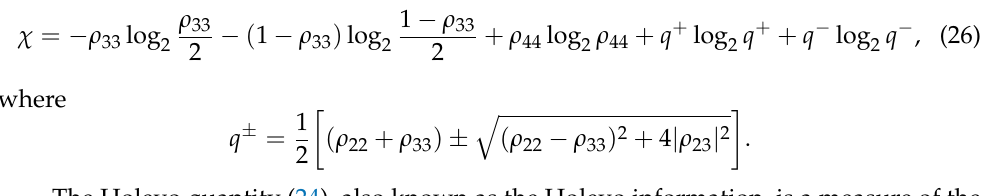
Figure 5. Dense coding capacity (26) as a function of the scaled time τ = γ 0 t when µ = 1/ for different values of Stark shift parameter β . ( a ) Non-Markovian regime with λ = 0.1 γ 0 and ( b ) Markovian regime with λ = 10 γ 0